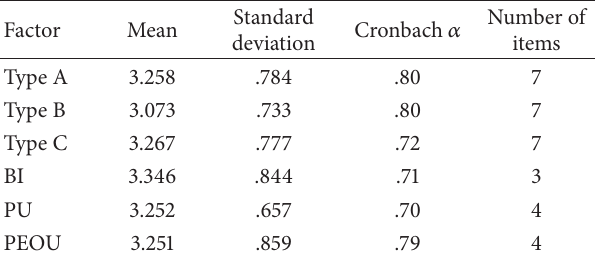
Table 2: Factor analysis for review types. Table 3: Customer reliability and descriptive statistics.